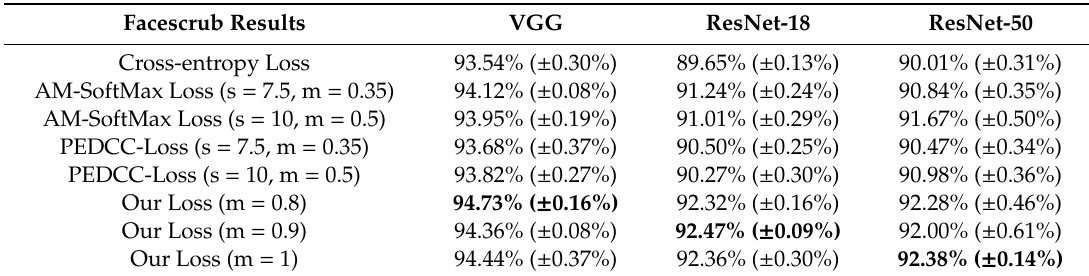
Table 3. The experimental results of Facescrub